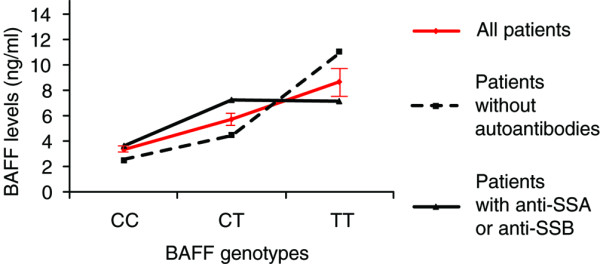
Association between BAFF -871 T/C polymorphism and serum BAFF level in 95 patients with pSS. The bar represents the standard error. BAFF = B-cell-activating factor; pSS, primary Sjögren's syndrome.